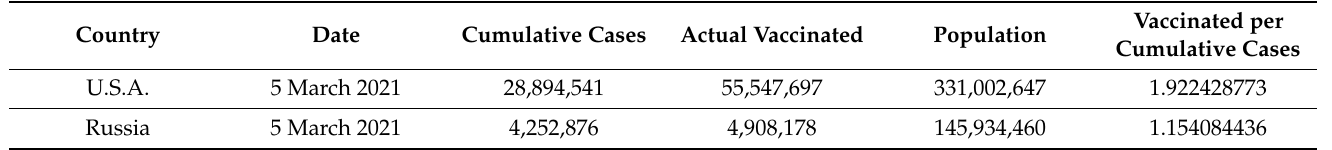
Table 10. Actual vaccinated people in third category countries